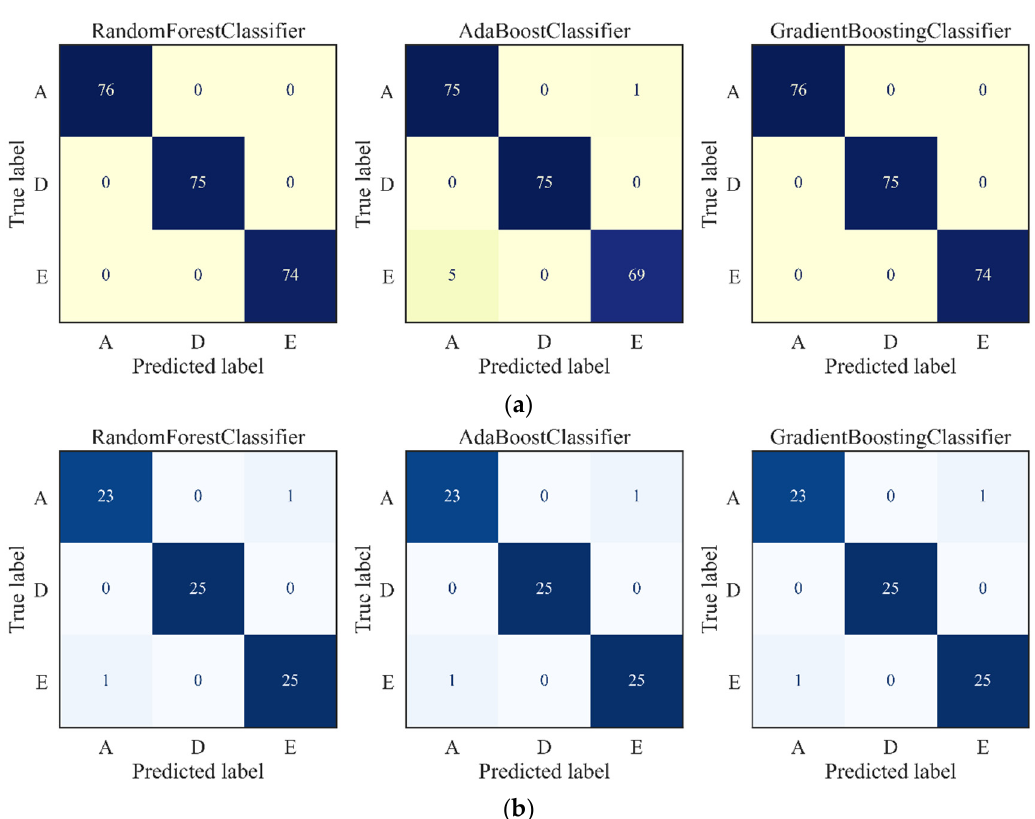
Figure 10. Prediction results using the AE-based features as inputs: ( a ) Confusion matrix of training, ( b ) confusion matrix of the test.